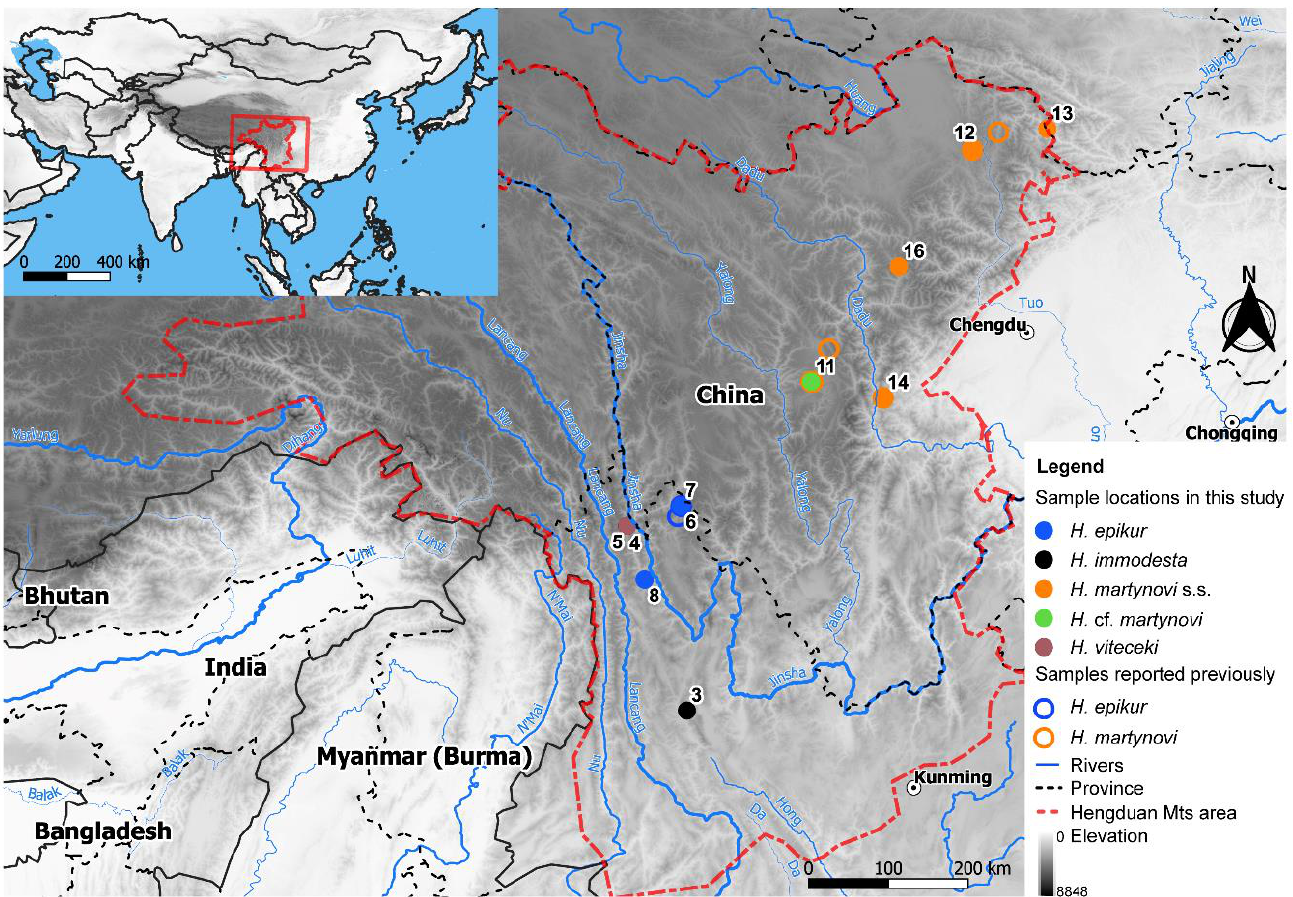
Figure 1. Sample locations of Himalopsyche species used in this study (solid dots) and compiled from the literature (hollow dots). H. martynovi s.s. is the abbreviation of H. martynovi sensu stricto.